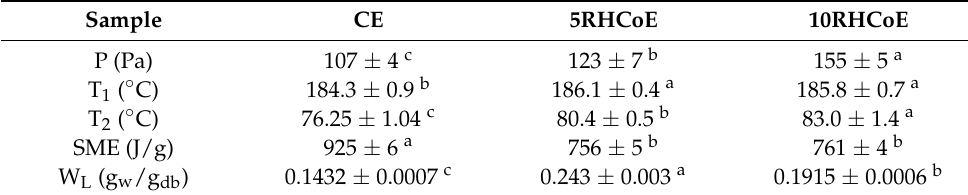
Table 1. Melt pressure ( p ), barrel temperatures (T 1 , T 2 ), specific mechanical energy (SME), and water loss (W L ) of studied samples. Mean values ± standard